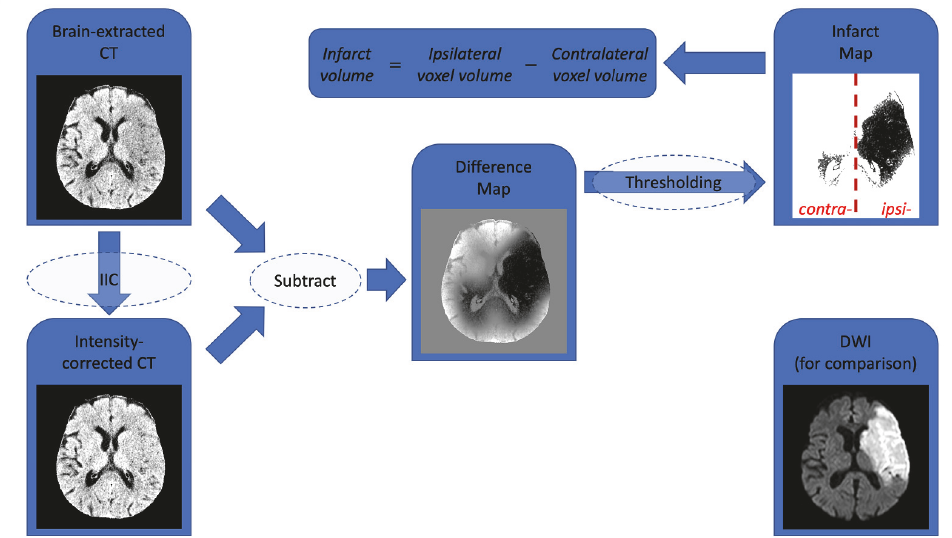
Figure 1: Illustration of the image processing pipeline. After brain-extraction, the NCCT is passed through IIC to generate the intensity- corrected or “restored” image. The input image is then subtracted from the product image to generate a difference map highlighting areas of reduced radiodensity. After thresholding, the volume of the contralateral hemisphere difference map is subtracted from volume of the ipsilateral hemisphere difference map to yield the infarct volume. An MR diffusion-weighted image of the same case performed the following day is included for reference.